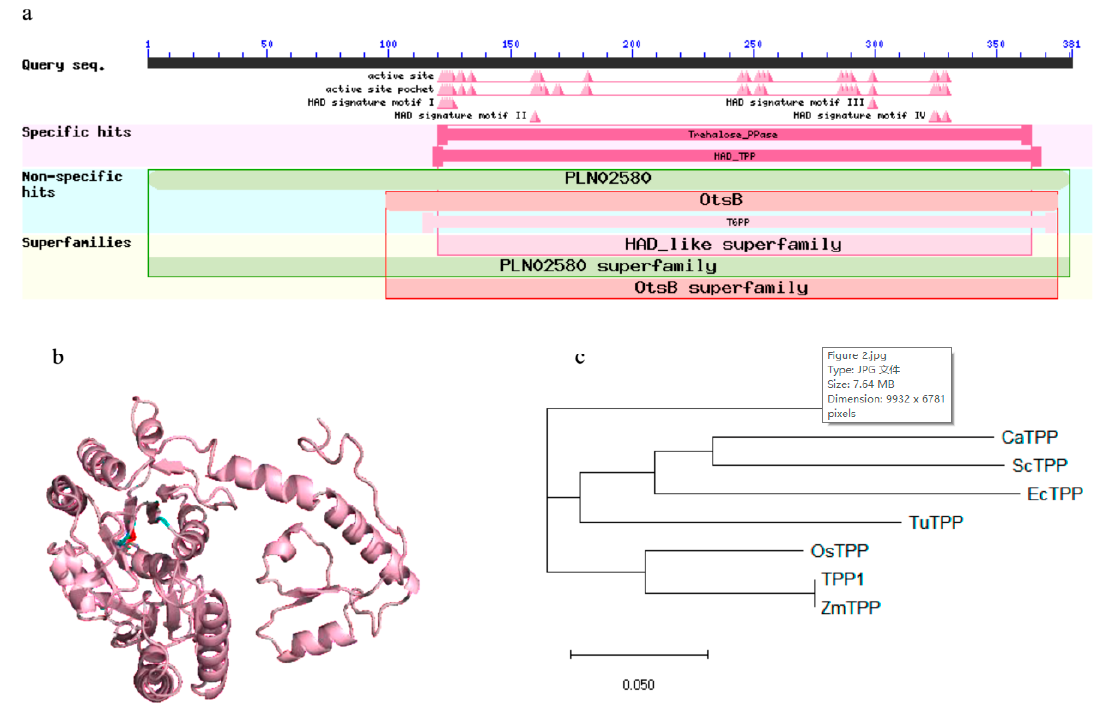
Figure 2. Amino acid sequence analysis and phylogenetic relationship of TPP-1 : ( a ) Domain analysis; ( b ) Computational modeling of TPP-1 ; ( c ) Phylogenetic tree of TPP amino acid sequence .